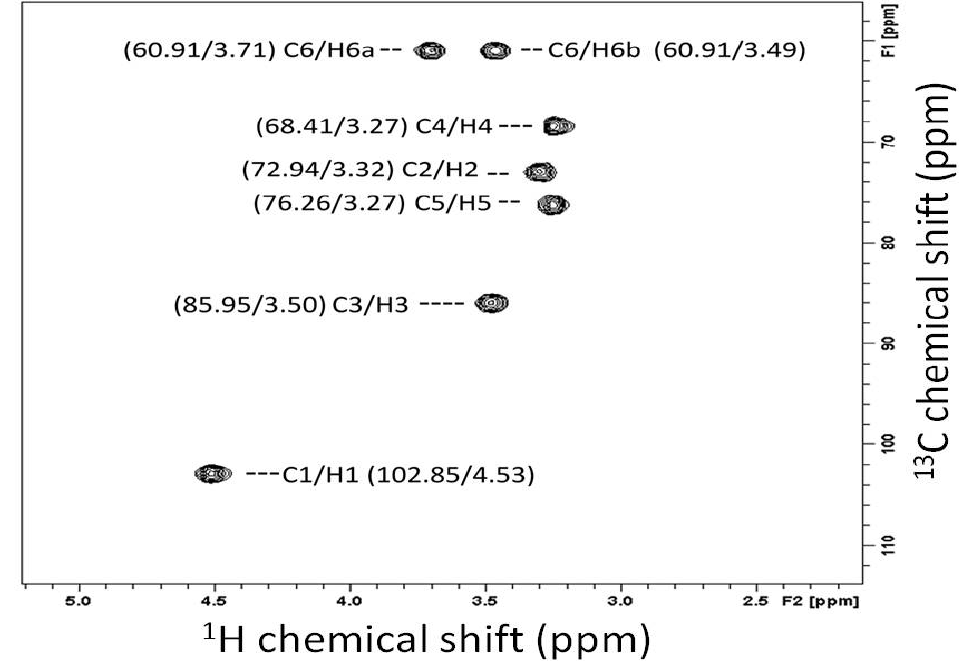
Figure 2. 1 H and 13 C HSQC spectra of the water-insoluble glucan isolated from the baker's yeast Saccharomyces cerevisiae . The 13 C NMR and 1 H NMR spectra are displayed on the vertical and horizontal axes,